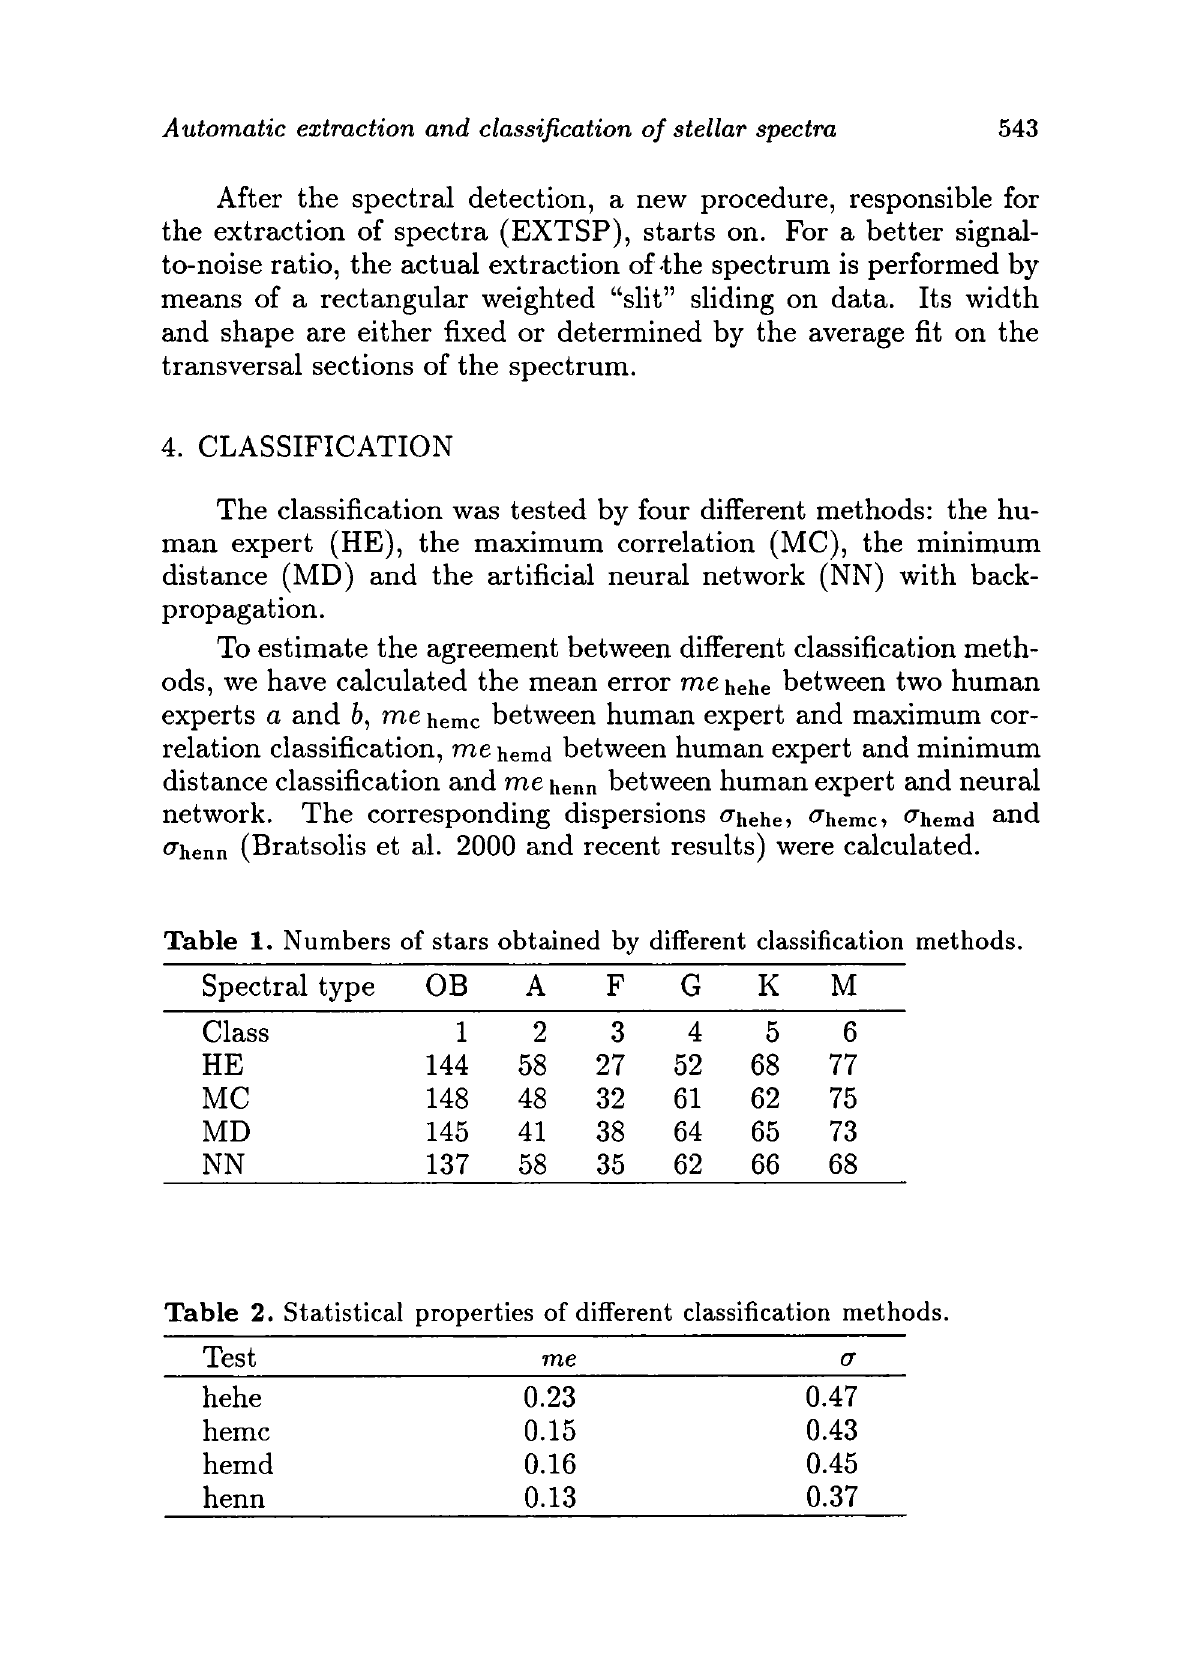
Table 2. Statistical properties of different classification methods.